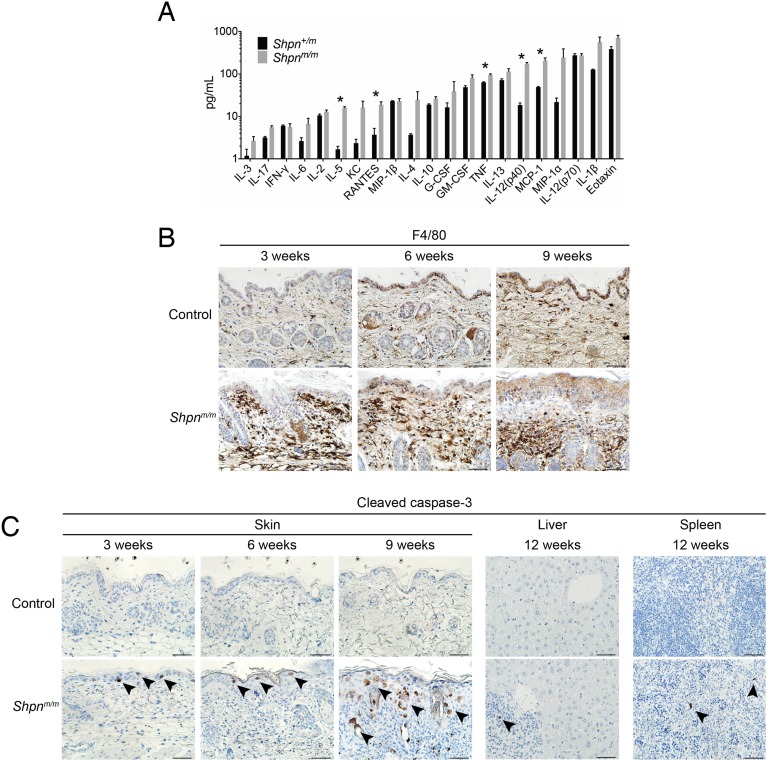
Keratinocyte cell death and dermal macrophage infiltration are early events in cpdm dermatitis.(A) BioPlex cytokine analysis of skin lysates from mice of indicated genotypes. Data are represented as mean +S.E.M. *p ≤ 0.05. (B) F4/80 staining (brown) of skin sections counterstained with hematoxylin (blue). Control: Shpn+/+ or +/m. (C) Cleaved caspase-3 staining (brown) of skin, liver and spleen sections counterstained with hematoxylin (blue). Black arrows show examples of cleaved-caspase-3 positive cells. Control: Shpn+/+ or +/m. (A–C) Three mice were analyzed for each genotype or group. Scale bars: 50 µm.